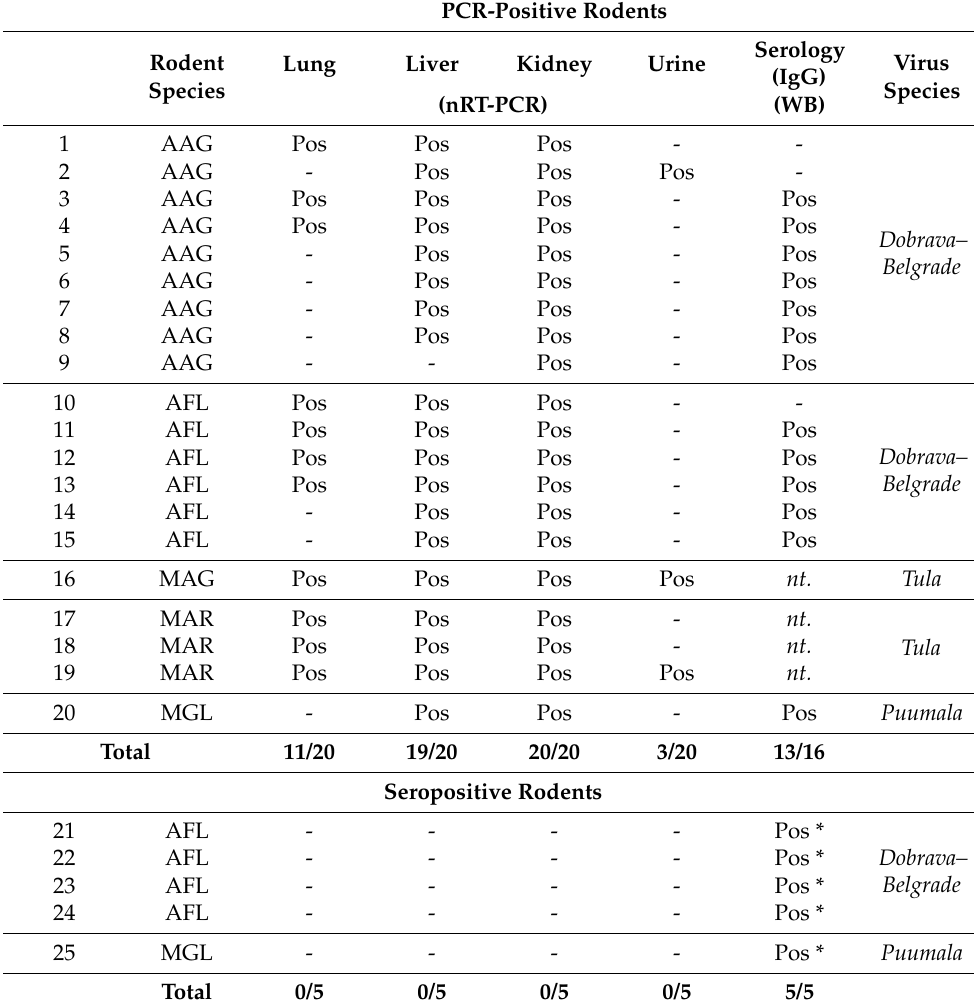
Table 1. Detailed molecular biological results of various organs and urine samples originating from rodents (nRT-PCR) along with the Western blot (WB) serological results and hantavirus species resulting from sequencing results (Abbreviations: AAG: Apodemus agrarius, AFL: Apodemus flavicollis, MAR: Microtus arvalis, MAG: Microtus agrestis, MGL: Myodes glareolus, nt.: not tested by serology, * only seropositive